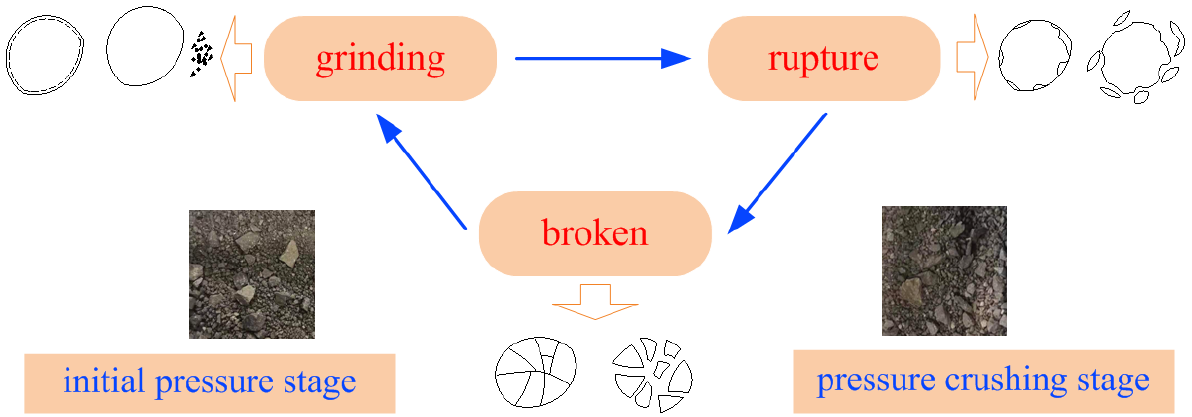
Figure 1. General pattern of re-crushing of coal rock particles.